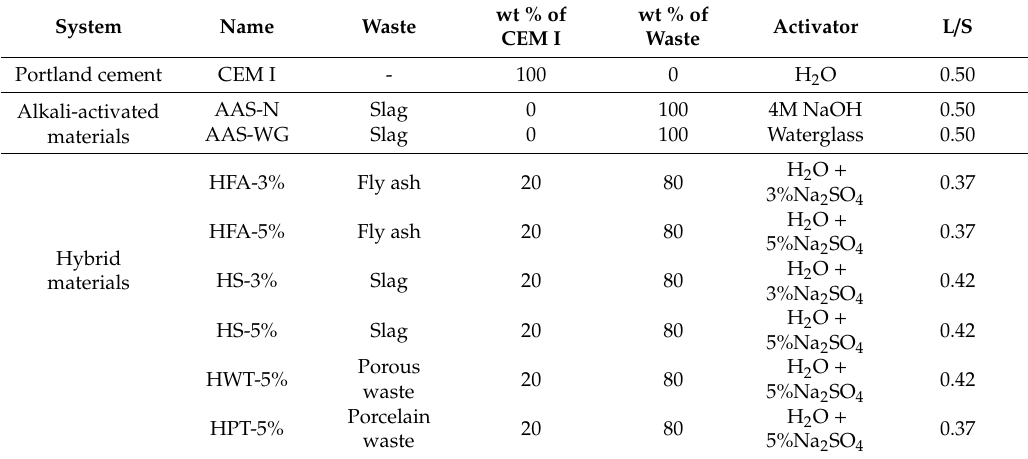
Table 3. Prepared mortars and activation